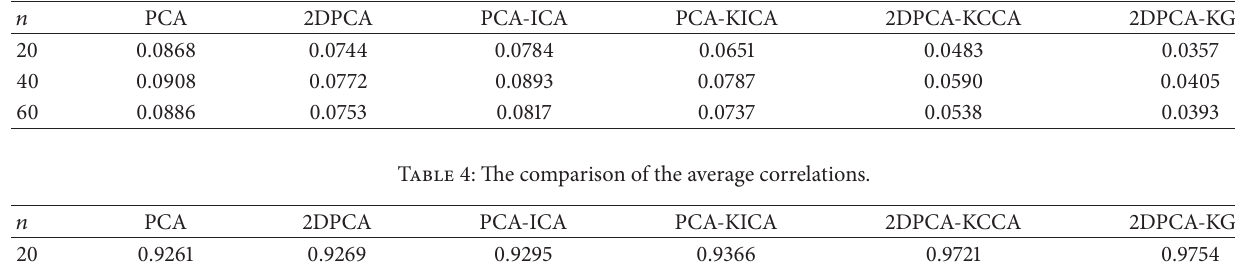
Table 3: The comparison of the average Amari errors.